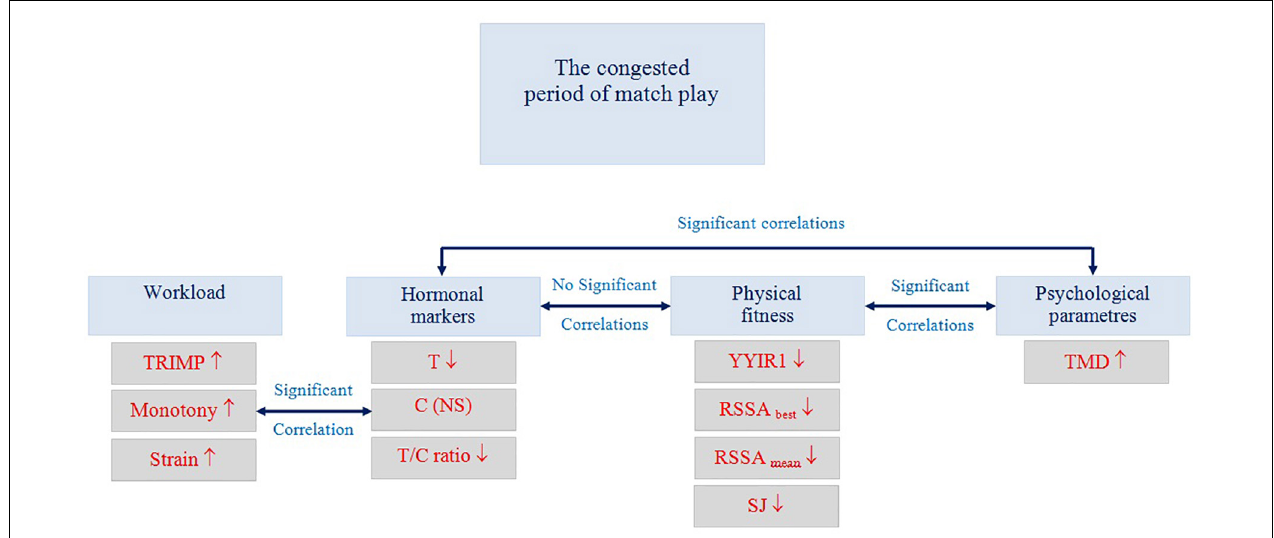
FIGURE 3 | Summary of the main findings of this study. TRIMP: Training Impulse. C: Cortisol. T: Testosterone. T/C: Testosterone/Cortisol ratio. YYIR 1: Yo-Yo intermittent recovery test level 1. SJ: Squat Jump. TMD: Total mood